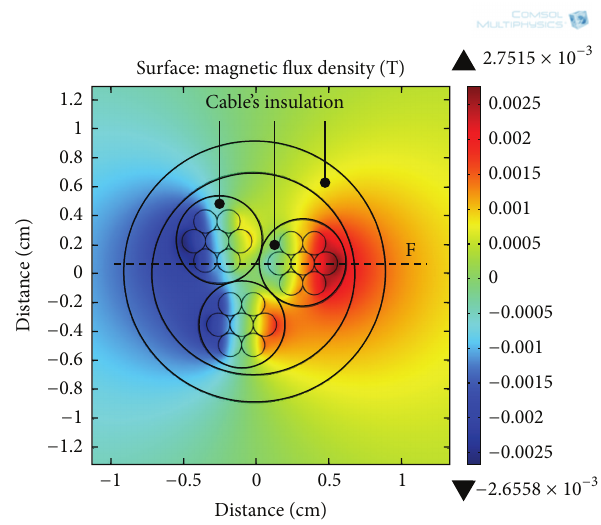
Figure 7: Distribution of a MFD along a cross-section of a three- core cable at a current level of 72 A.